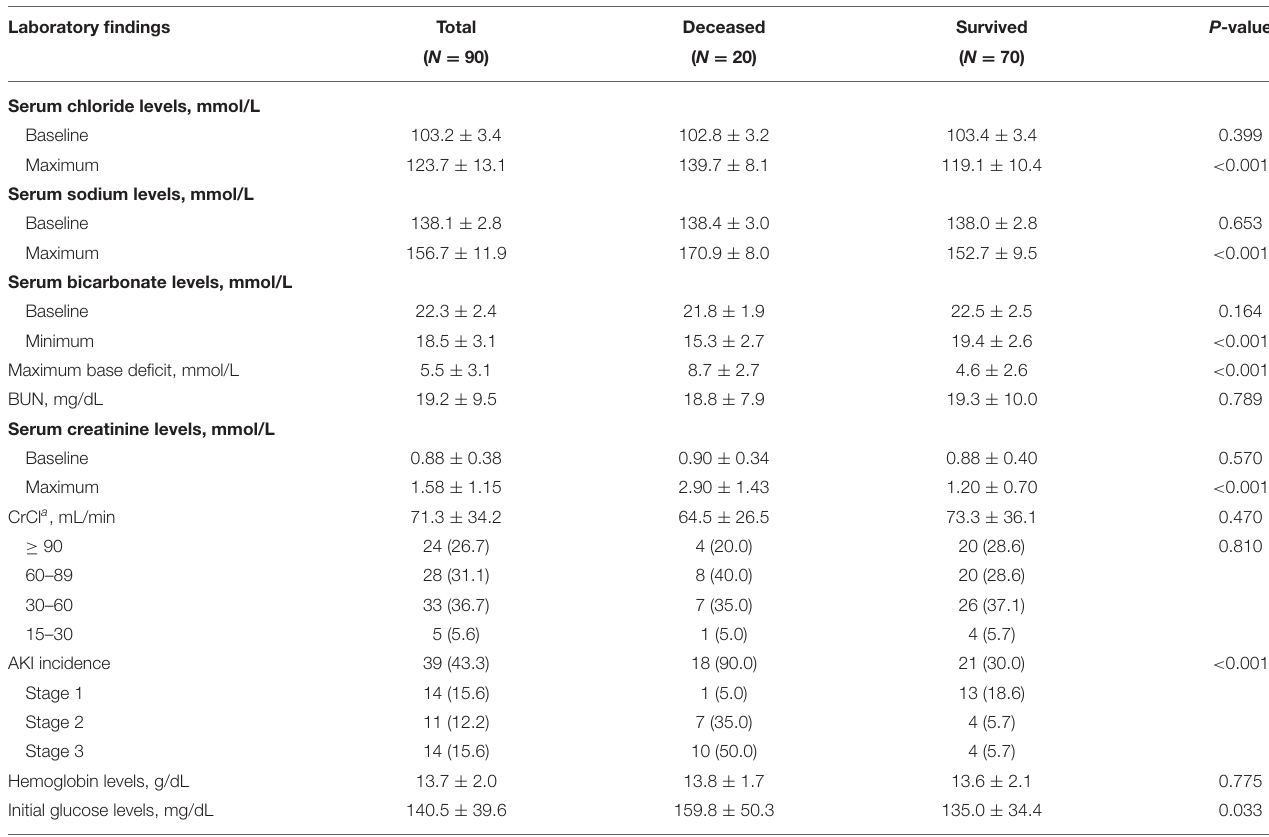
TABLE 2 | Laboratory findings and acute kidney injury